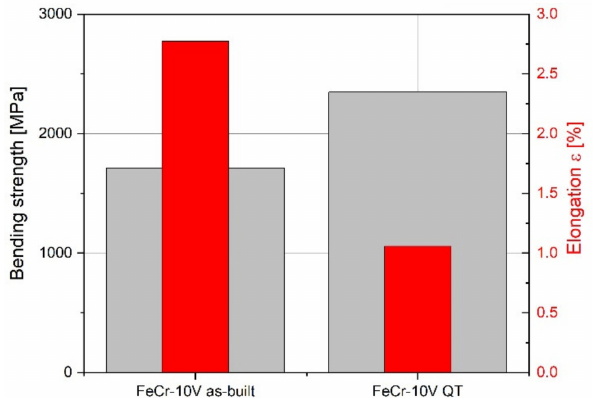
Figure 10. Three-point bending test for the as-built and heat-treated (QT) FeCr-10V PBF-EB mechani- cal test